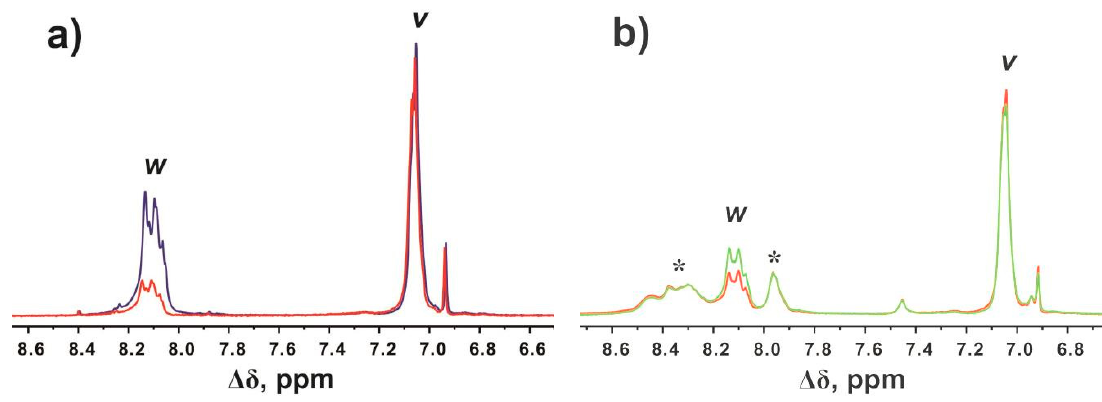
Figure 6. Evolution of the peak at 8.12 ppm from protons at the C 2 carbons of the imidazole rings of histidine residues in Lys-2His dendrimer: ( a ) 1 H NMR spectra of Lys-2His dendrimer in D 2 O before (blue) and after (red) heating; ( b ) 1 H NMR spectra of Lys-2His dendrimer in H 2 O before (red) and after (green) heating. The peaks from protons in the NH groups are indicated by *.